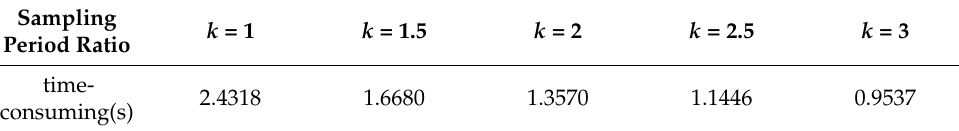
Table 3. Time consuming of algorithms with different values of k .